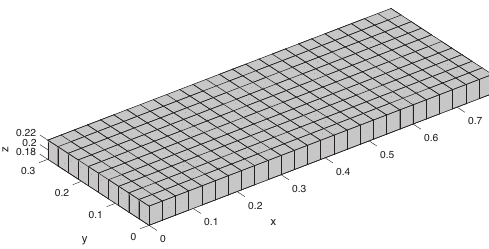
Figure 1. Geometry of the plate used in the numerical